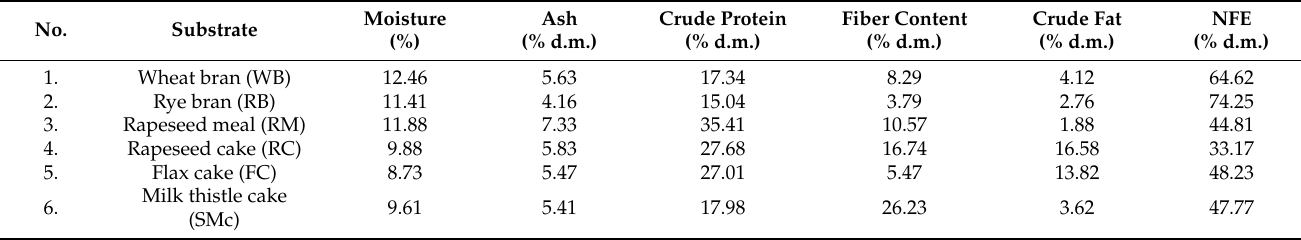
Table 1. Main components of agro-industrial byproducts used for experimental